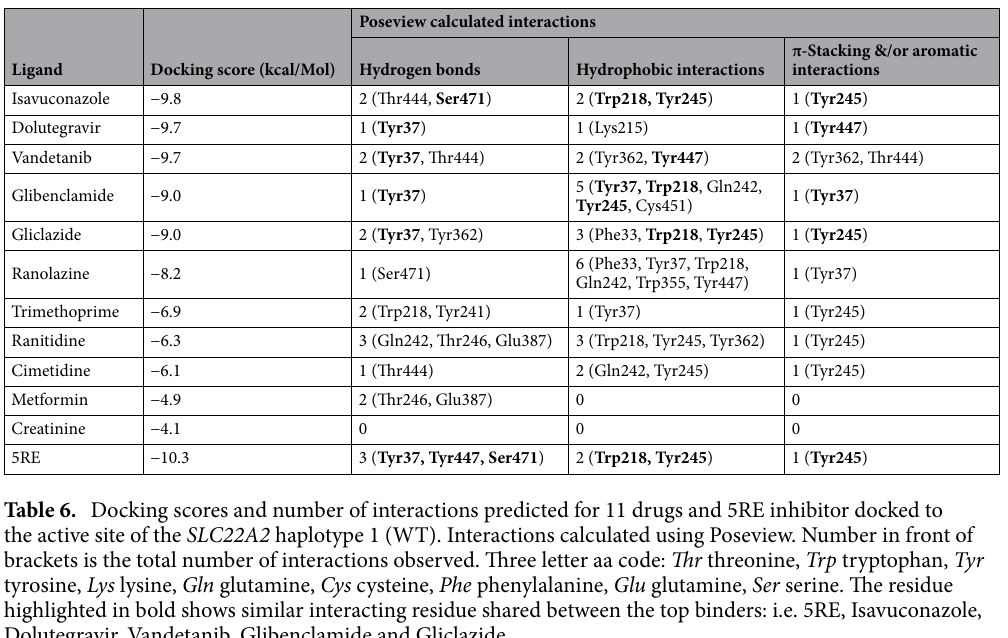
Poseview calculated interactions Hydrogen